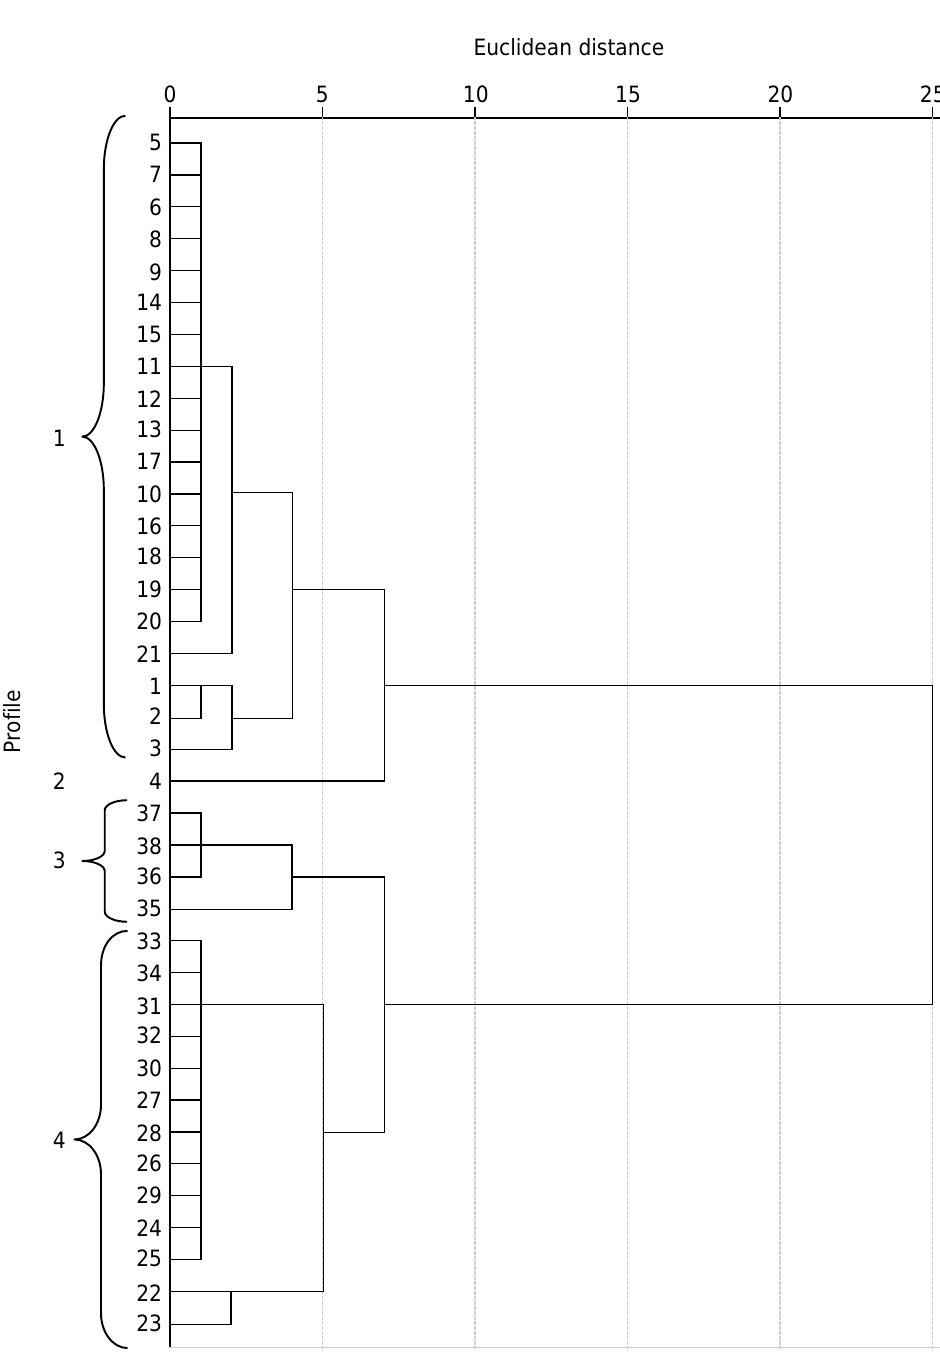
Figure 2. Dendrogram of the soil profiles of similarity (I – 1-4; II - 5-21; III - 22-34; IV - 35-38) evaluated in different altitude regions of the state of Santa Catarina,